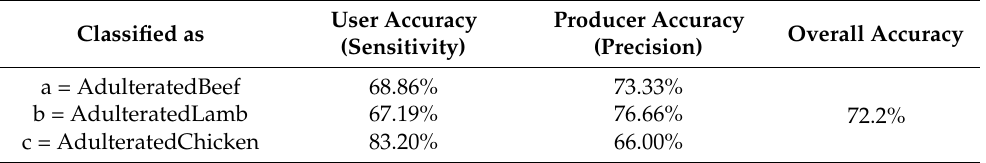
Table 8. Sensitivity, precision, and classification accuracy for adulterated samples of beef, chicken, and